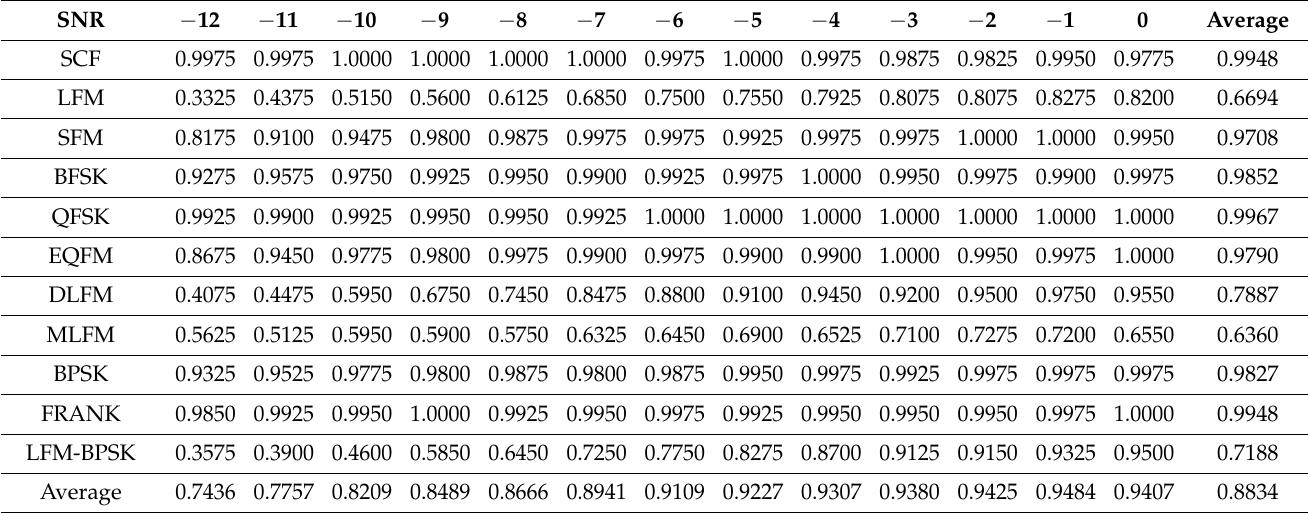
Table A11. Semi-supervised classification results with the datasets in Situation Dataset 5 ( T cycle = 200, NUM = 276).